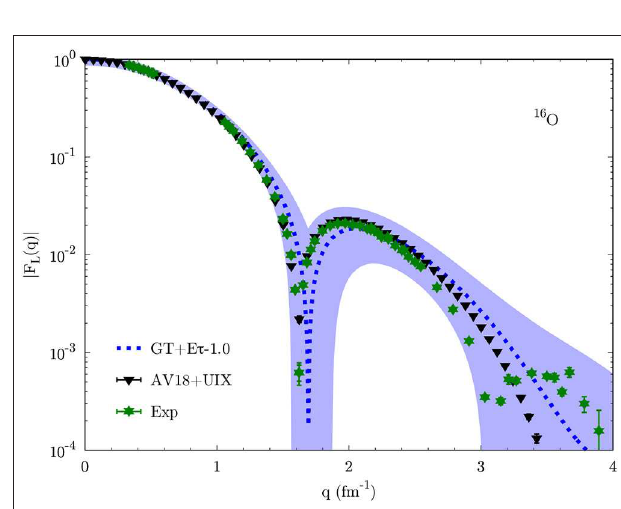
FIGURE 9 | Same as Figure 7 but for 16 O. Experimental data are from Sick, based on references [136–138]. Adapted from reference